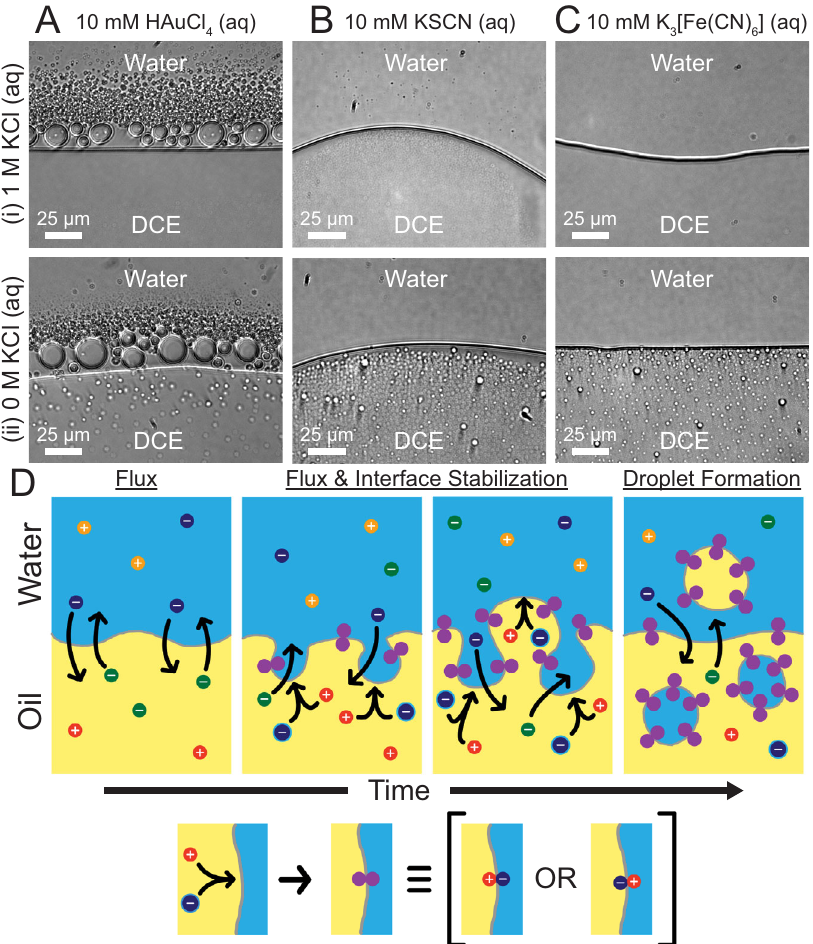
Fig. 6 | Emulsi fi cation achieved with different transferring ions, the effect of aqueoussaltconcentration,andproposedmicroscopicmodelof fl ux-induced emulsi fi cation. Light microscopy images were taken at the water|DCE boundary when the aqueous phase contained 10mM HAuCl 4 ( A ), KSCN ( B ), or K 3 [Fe(CN) 6 ] ( C ) with either 1M KCl (i) or 0M KCl (ii). The DCE phase always contained 0.1M